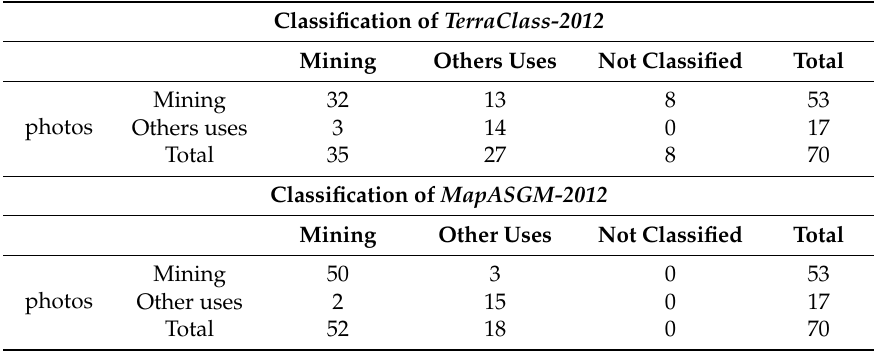
Table 2. Matrix of validation of TerraClass-2012 and MapASGM-2012 land use classification having aerial photos as ground-truth. Overall accuracy is 64% for TerraClass-2012 and 93% for MapASGM-2012 . Classification of TerraClass-2012 Mining Others Uses Not Classified Total Mining 32 13 8 53 photos Others uses 3 14 0 17 Total 35 27 8 70 Classification of MapASGM-2012 Mining Other Uses Not Classified Total Mining 50 3 0 53 photos Other uses 2 15 0 17 Total 52 18 0